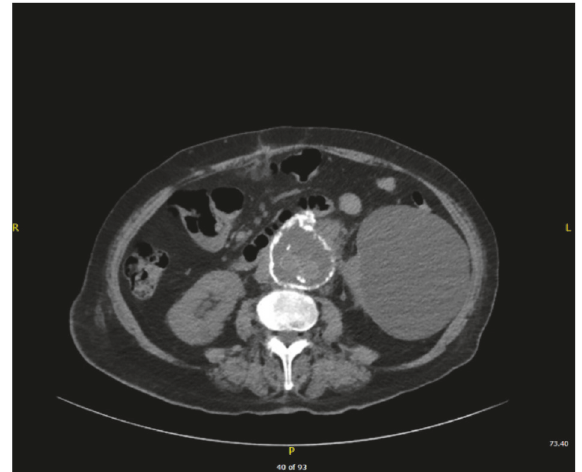
Figure 1: Computed tomography of abdomen showing nonspecific findings, irregularity of the “aneurysmal sac” with a small amount of fluid around the sac.